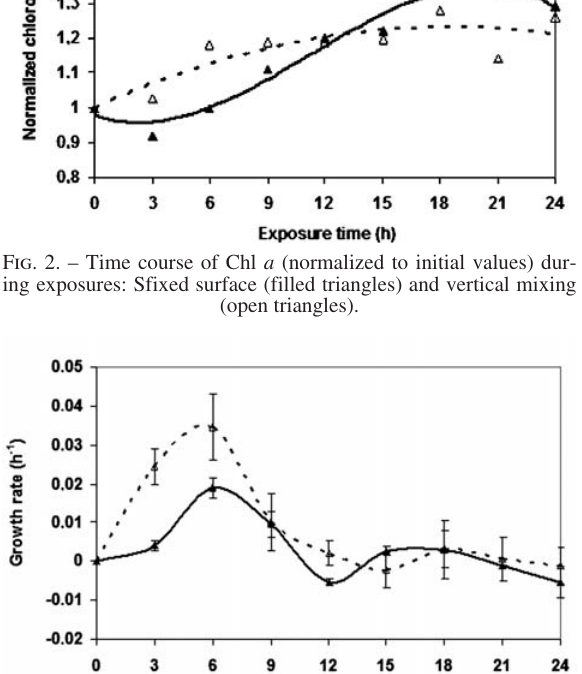
Fig . 5. – Time course of normalized to initial values cell contents of Porphyra-334 (a) and Shinorine (b) during exposures: Sfixed sur- face (filled triangles) and vertical mixing (open